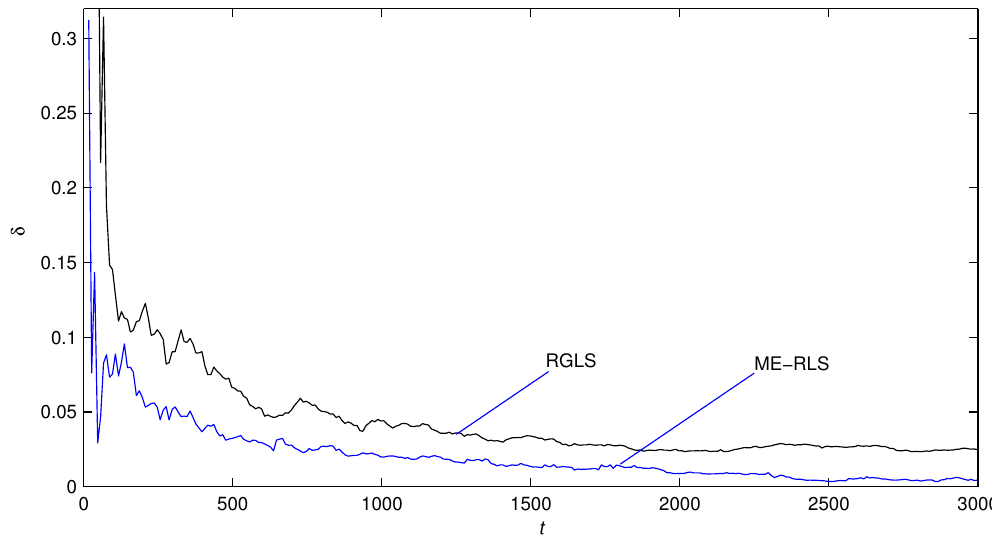
Figure 2. The parameter estimation errors δ versus t